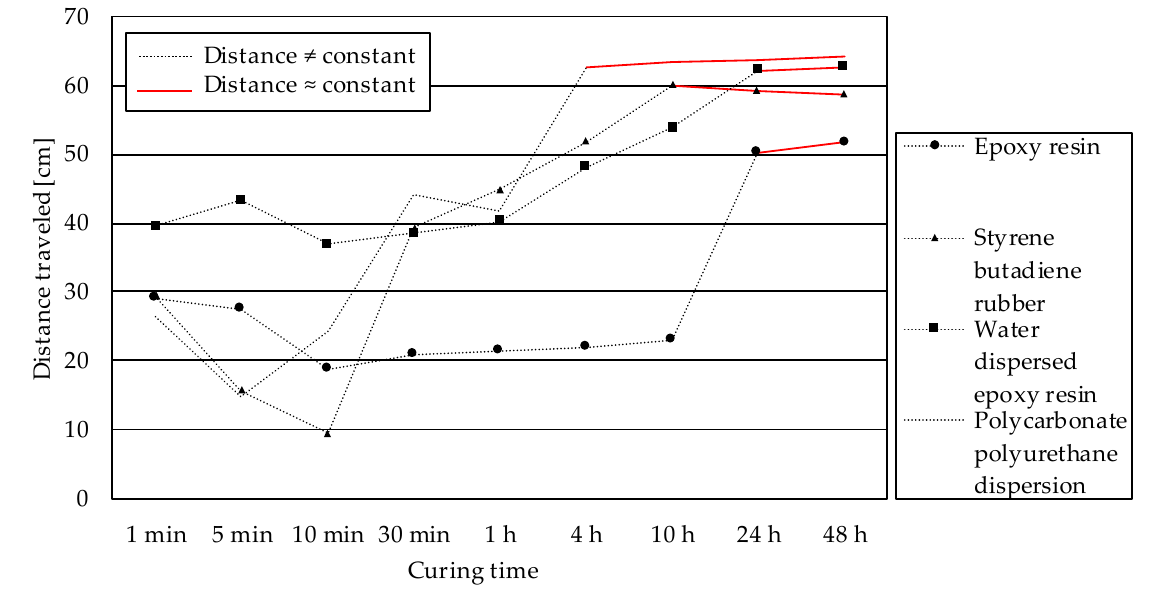
Figure 7. Development of distance traveled by the steel ball across an impregnated textile in the rolling ball test over time.